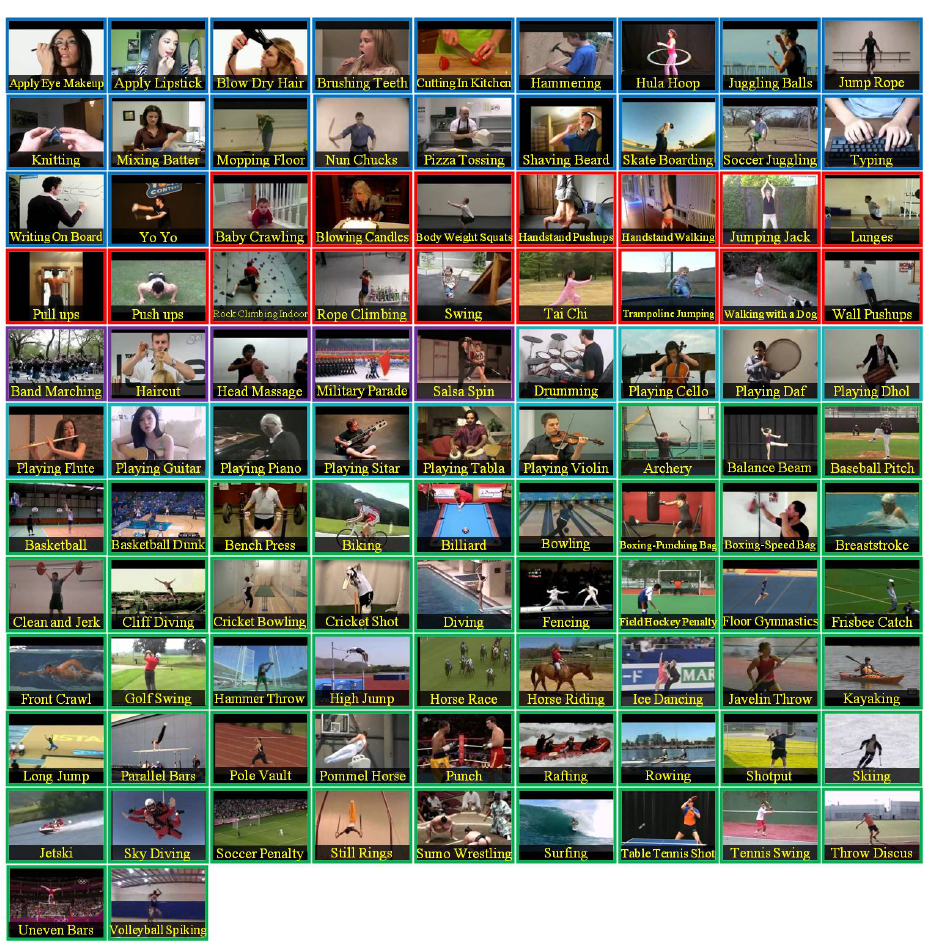
Figure 8. Sample images from the UCF101 Dataset